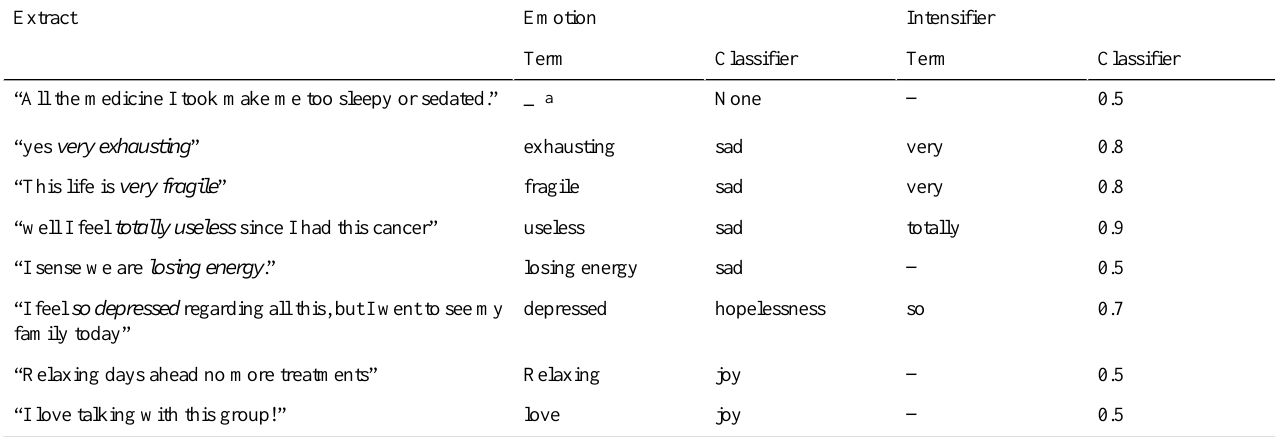
Table 3. Demonstration of emotion intensity calculation. IntensifierEmotionExtract